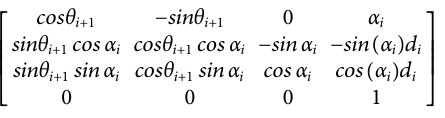
FIGURE 3 Calculationoftherotationangleofasinglejointclosesttothe target point in